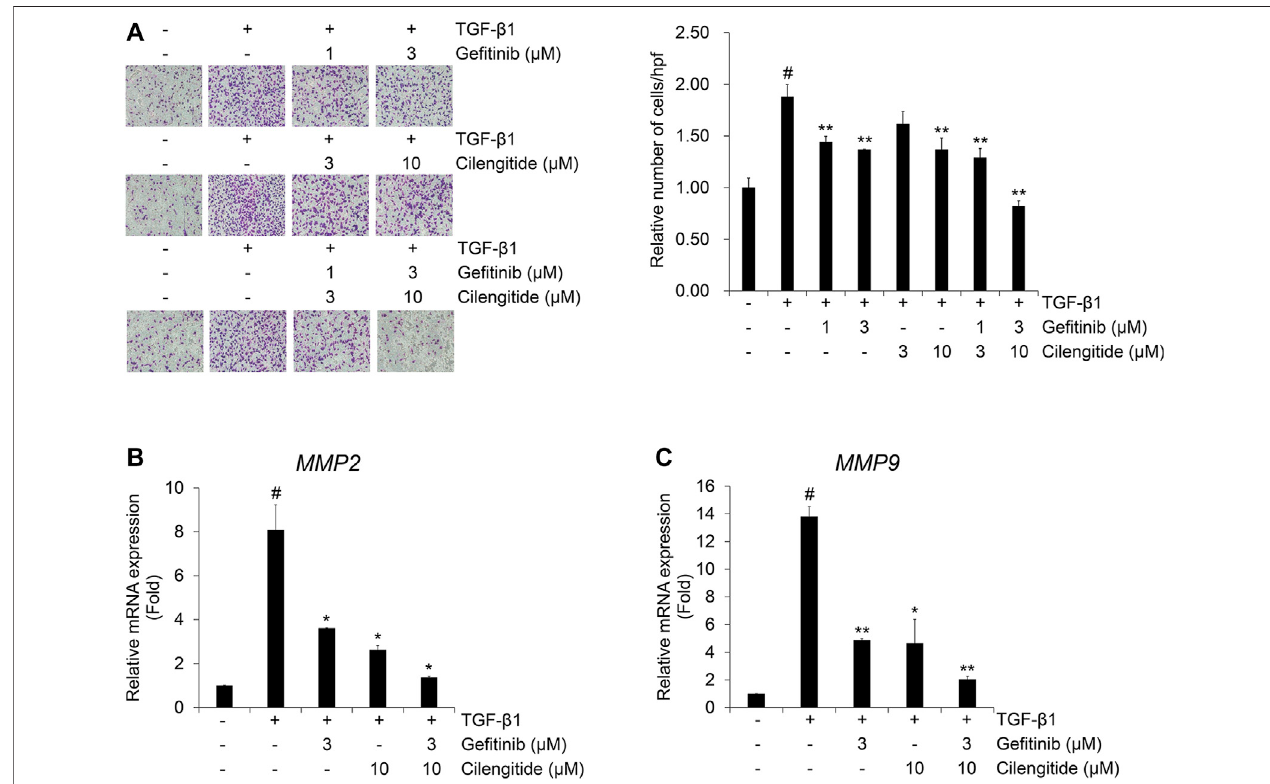
FIGURE 7 | Combination of ge fi tinib and cilengitide exerts an enhanced inhibitory effect on TGF- β 1-induced invasion of A549 cells (A – C) Serum-deprived A549 cells were treated with TGF- β 1 (5 ng/ml) with or without cilengitide for 48 h. (A) The effect of the combination on TGF- β 1-induced invasion of A549 cells was evaluated using Boyden chambers. Numbers ofinvadedcells arepresentedasanaveragenumber ofcells per threerandomlyselectedhigh-power fi elds (HPFs). (B, C) AfterRNA extraction and cDNA synthesis, we performed qRT-PCR to measure expression of MMP2 and MMP9 mRNA using GAPDH as an internal control. Experiments were performed in triplicate. Data represent the mean ± SD of raw results. # p < 0.01 vs. control;* p < 0.05, ** p < 0.01 vs. treatment with TGF- β 1